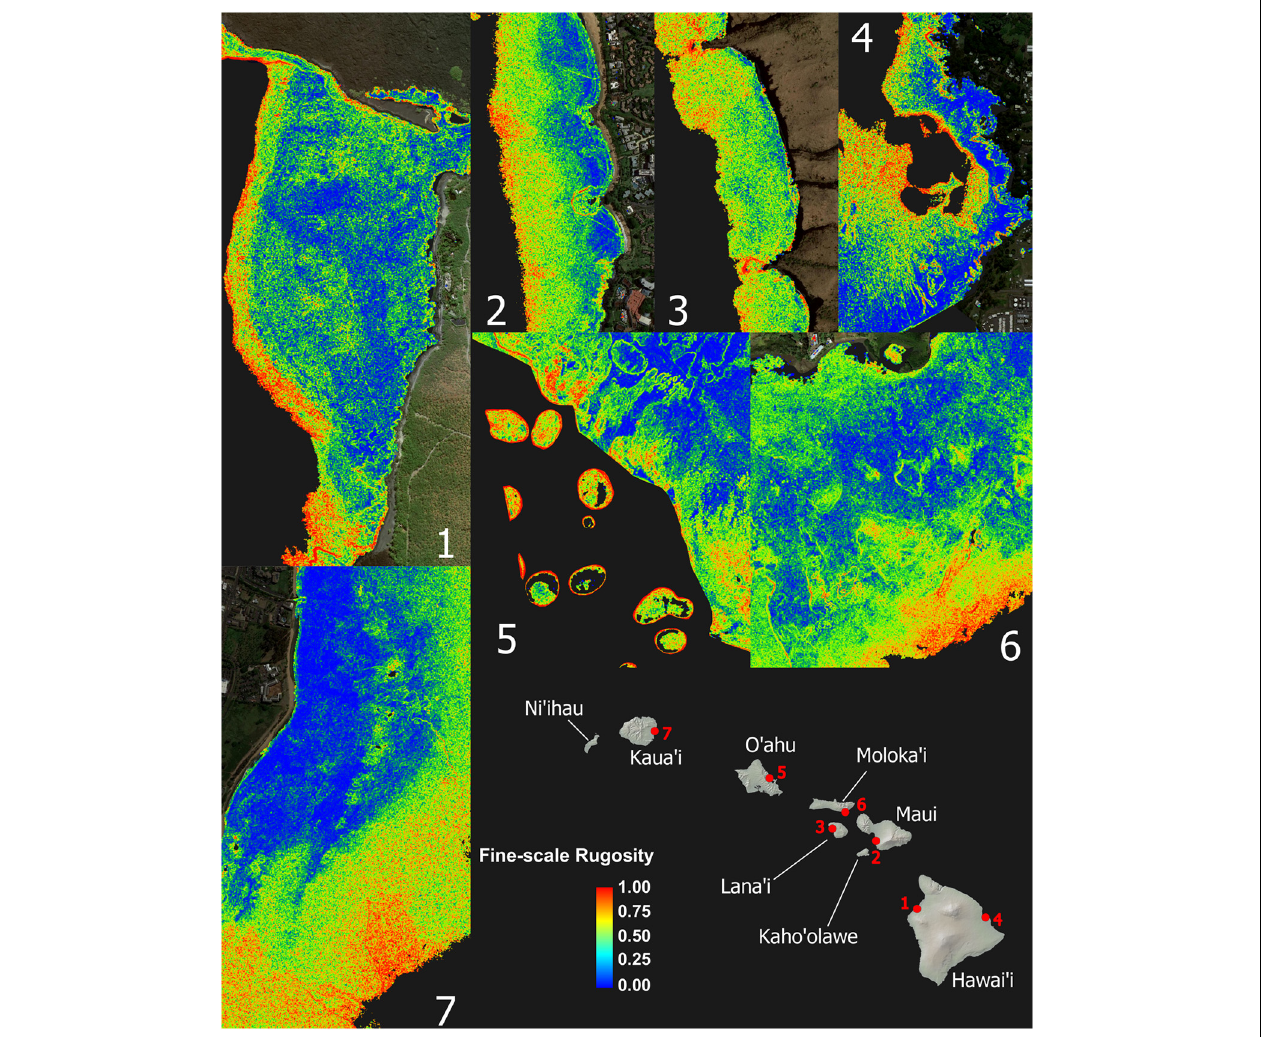
FIGURE 3 | Zoom images from maps shown in Figure 2 demonstrating high spatial frequency variation and pattern in the fine-scale rugosity. These seven example reefs encompass the range of conditions among high-rugosity sites. Coarse-scale rugosity is provided in Appendix Figure A2 .